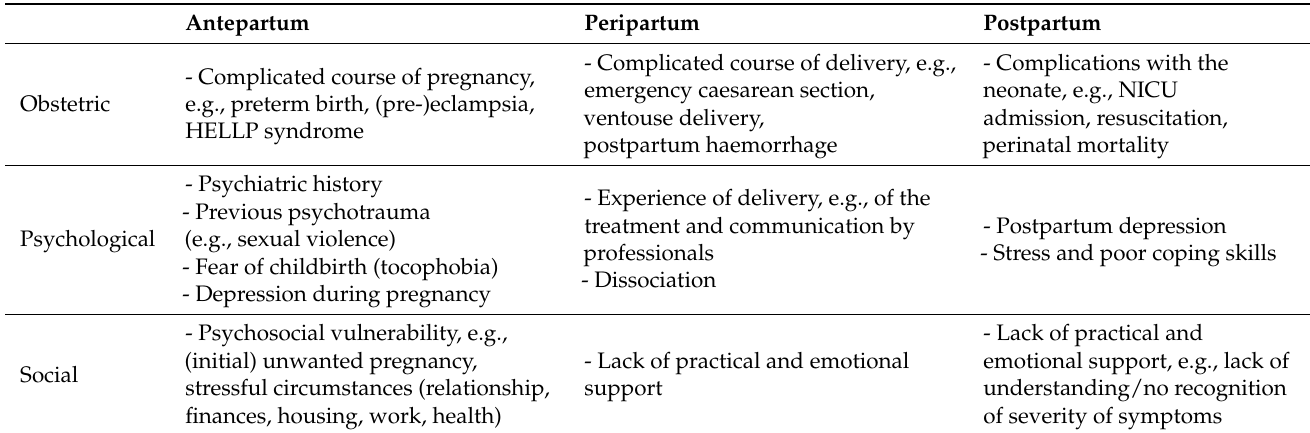
Table 2. Risk factors for childbirth-related